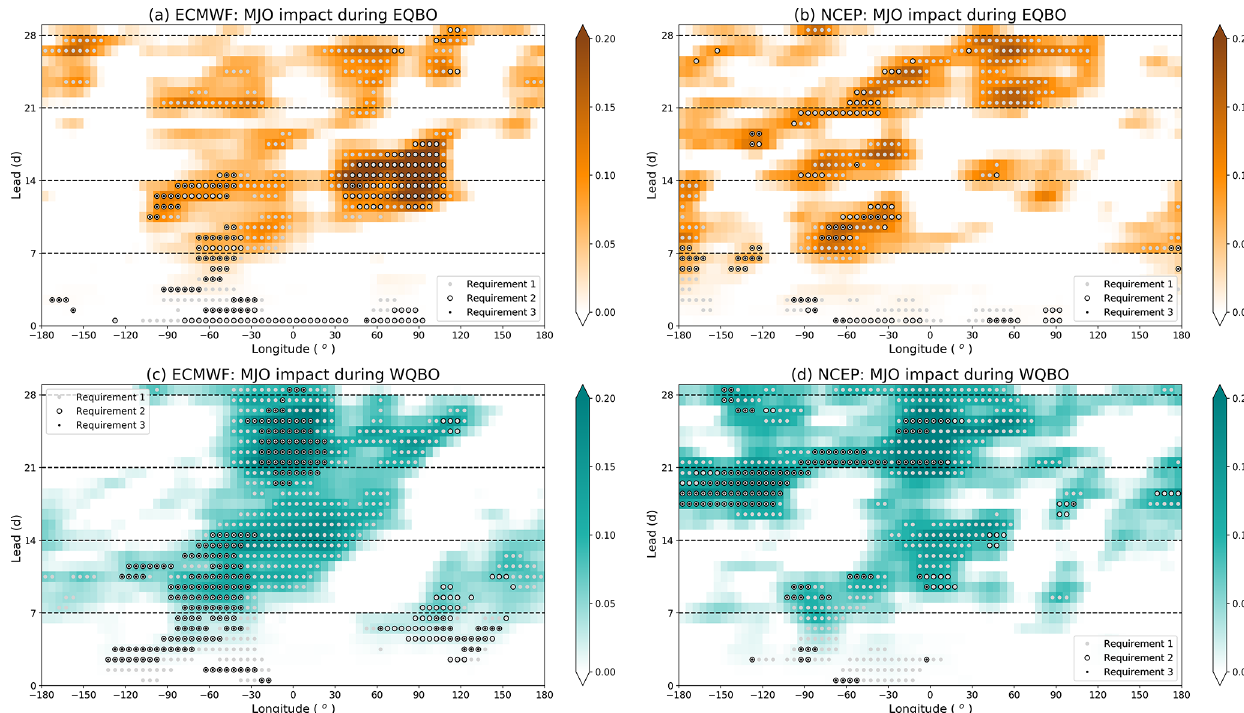
Figure 5. Anomalous correlation coefficient between the (a, b) EQBO–MJO and EQBO–noMJO and (c, d) WQBO–MJO and WQBO– noMJO for (a, c) ECMWF and (b, d) NCEP at each longitude and lead from model initialization. Correlations are calculated within a 60 ◦ wide box, centered on each longitude, extending from 30 to 60 ◦ N. Shading denotes the phase of the QBO. Grey dots denote regions and leads where requirement one is passed at 90% confidence. Black circles indicate regions and leads where requirement two is passed at 90% confidence, and small black dots indicate regions and leads where requirement three is passed at 90% confidence. See the text for